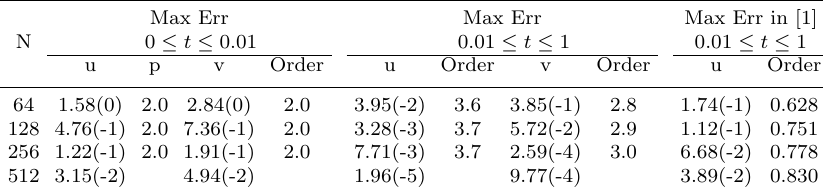
Table 5. Numerical results and comparisons of Example 5. Max Err Max Err Max Err in [1] N 0 ≤ t ≤ 0 .